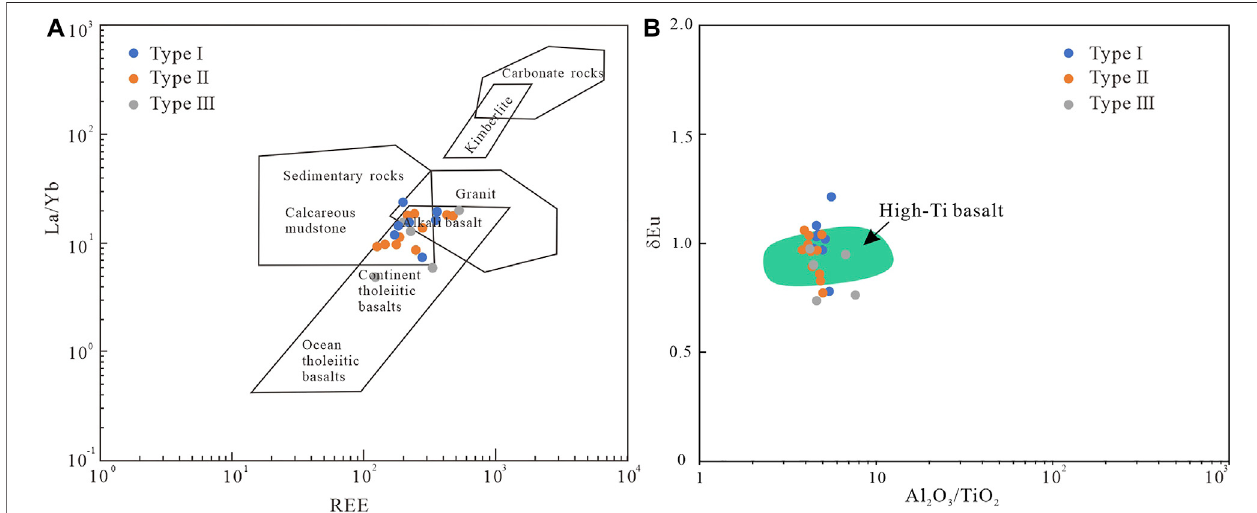
FIGURE 7 | Provenance analysis, (A) La/Yb vs. REE diagram; (B) δ Eu vs. Al 2 O 3 /TiO 2 diagram (data for high-Ti basalt are from Xiao et al., 2004).